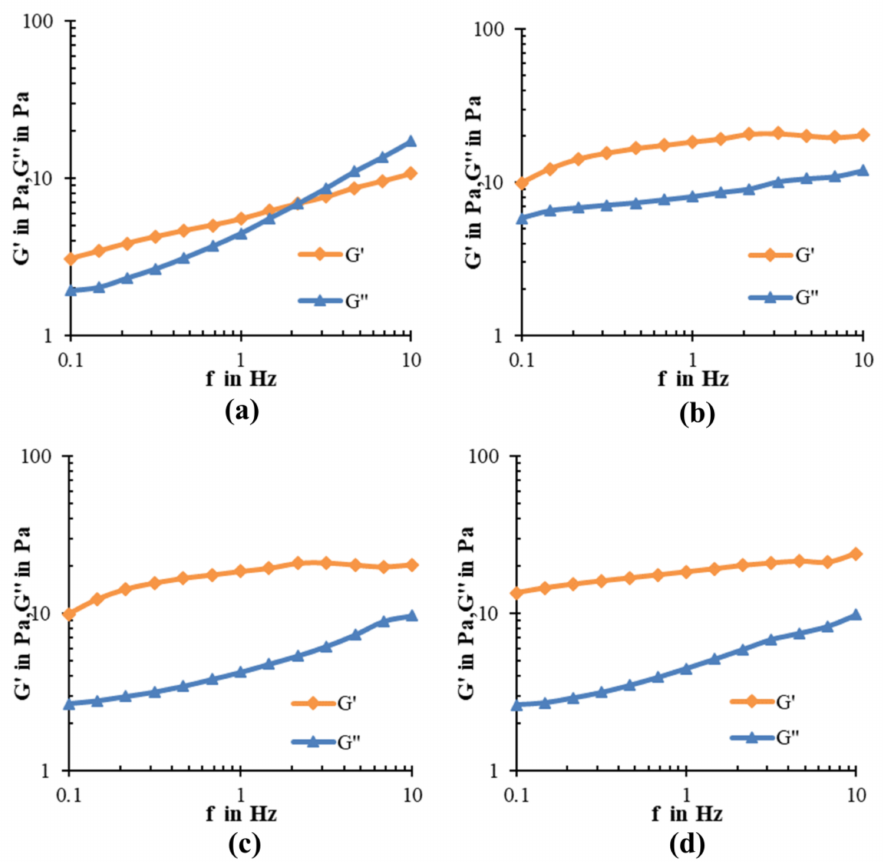
Figure 4. Frequency sweep of ( a ) Control ( b ) T1 ( c ) T2 ( d ) T3 ice cream at a strain of